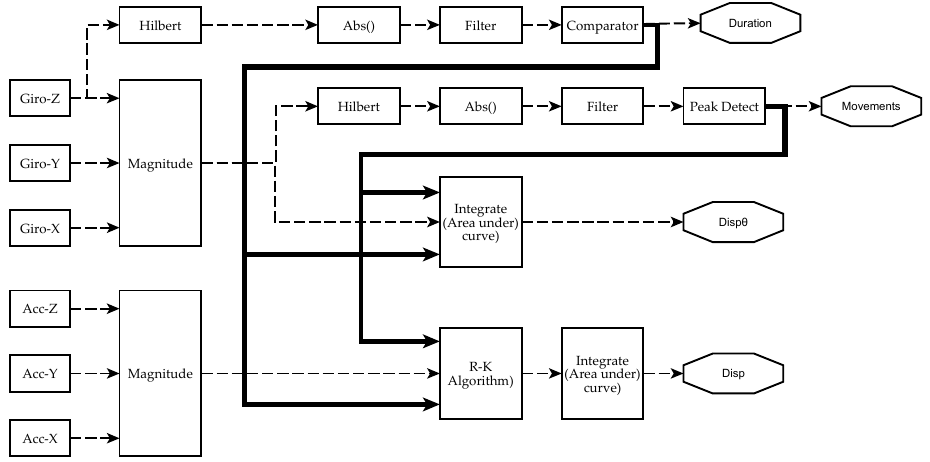
Figure 5. Scheme of signal processing and information analysis to obtain manual dexterity metrics on each sensor. Currently, four metrics have been achieved from IGlove’s raw signals: Duration of exercises ( Duration ), the number of movements during each exercise ( Movements ), spatial displacement ( Disp ), and angular displacement ( Disp θ ). The absolute value of the Hilbert transform of a gyroscope signal is filtered to obtain a smoothened signal that is higher than 0 when the hand moves. A comparator decides when the level and duration of a perturbation in the signal were enough to mark it as an exercise. The metric Duration of an exercise is the difference between the end and the beginning of a significant perturbation. Variable Movements is calculated from the magnitude of angular speed S ω (computed from all gyroscopes using Equation (1)). It was observed that peaks on S ω indicate when a movement was performed. To estimate the number of moves, S ω is smoothened, but this time, a peak detector identifies the spikes in the signal that were large enough and have been caused by a valid hand movement. The area under S ω was calculated using numerical integration to estimate Disp θ . Spatial kinematic parameters were estimated from accelerometers signal S a (calculated using Equation (3)), Runge–Kutta method was used to obtain an approximate time series for the magnitude of velocity V a . Finally, spatial displacement is calculated as the area under the curve of | V a ( t ) | . When performing numerical integration, Duration and Movements parameters were used to establish integration limits and estimate initial conditions.